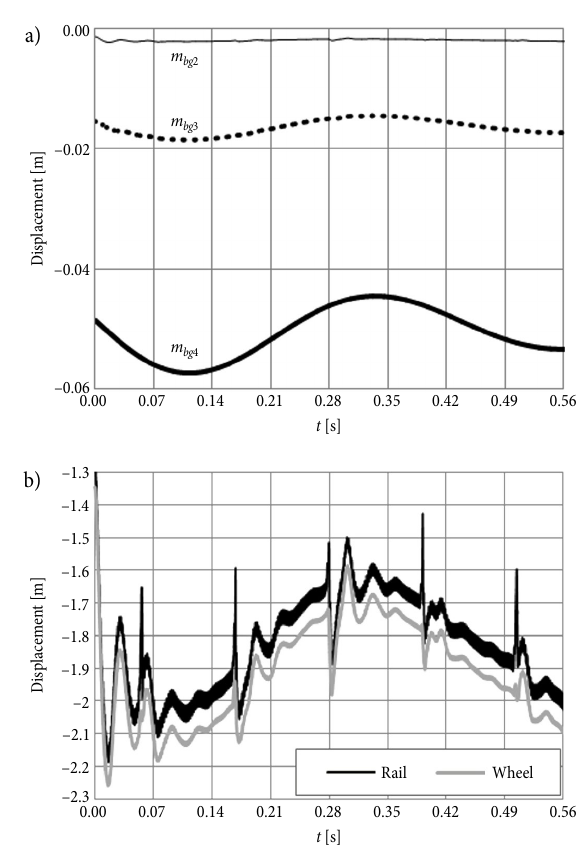
Fig. 14. The history of time for displacements: a – wheel flat ( L = 100 mm); b – wheel and